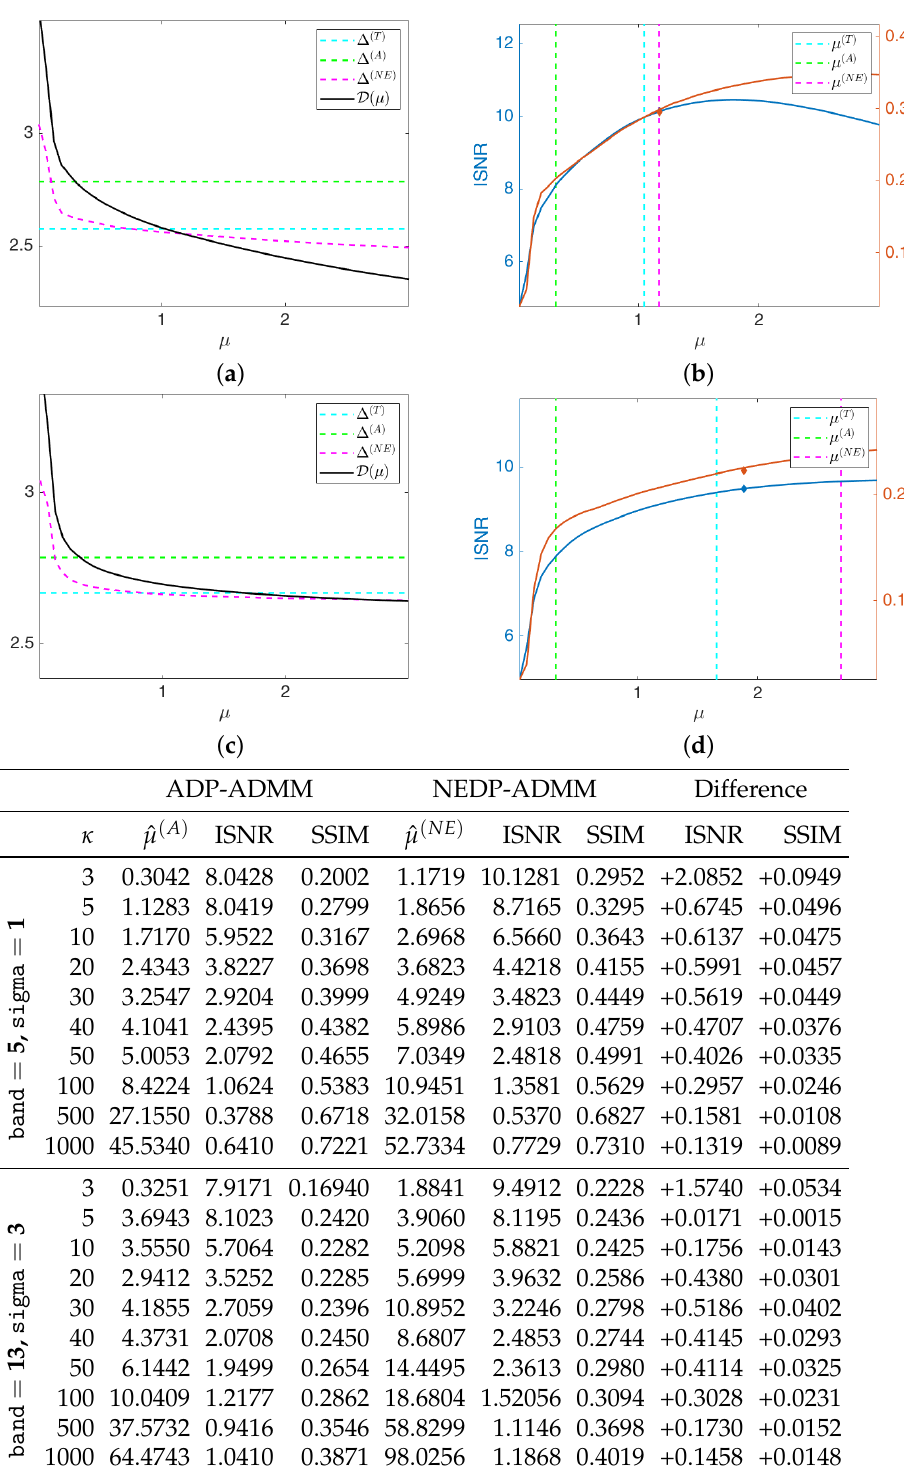
Figure 15. Test image cells . Top : discrepancy curve divided by 10 4 ( a , c ) and ISNR/SSIM values ( b , d ) achieved for different µ -values with κ = 3 and Gaussian blur with parameters band = 5, sigma = 1 ( first row) and band = 13, sigma = 3 ( second row). Bottom : output µ -values and ISNR/SSIM values obtained by the ADP-ADMM and the NEDP-ADMM for the two blur levels considered and different photon counts κ